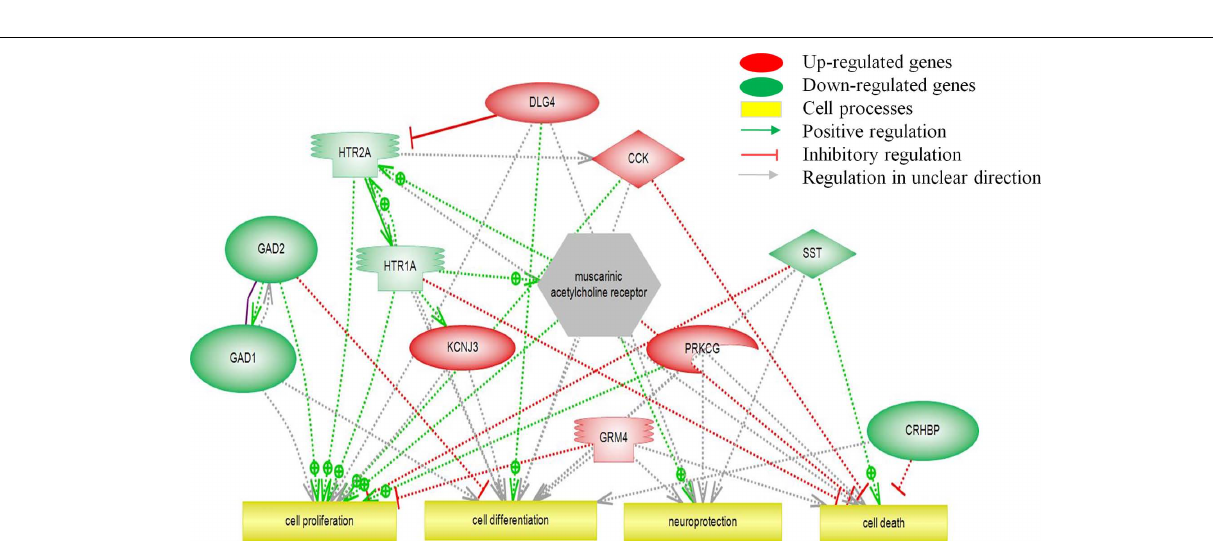
FIGURE 4 | Pathway analysis of transcripts ( p < 0.05) involved in cell